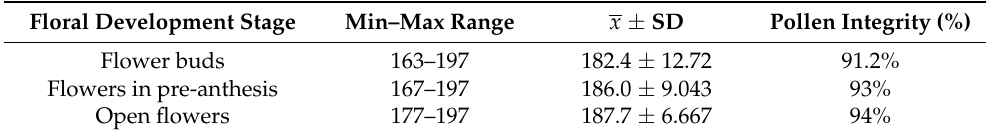
Figure 5. Results of the pollen integrity and stigma receptivity tests and the presence of osmophores in flowers of D. sericea collected in the surroundings of the PESNT. ( A ) Acetocarmine-stained pollen, V = viable, and non-stained pollen, I = inviable, bar = 50 µ m; ( B ) sign of stigma receptivity from a reaction to hydrogen peroxide in a pre-anthetic flower and ( C ) in a blooming flower, bar = 0.5 cm; ( D ) neutral red-positive coloration of scent glands in the petals and stamens or staminodes: above, male flowers ( ), below, female flowers ( ), bar = 1 cm. ♀ ♂ Table 3. Pollen integrity (%) tested in flower buds, flowers in pre-anthesis, and open flowers of D. sericea from individuals located in the surroundings of